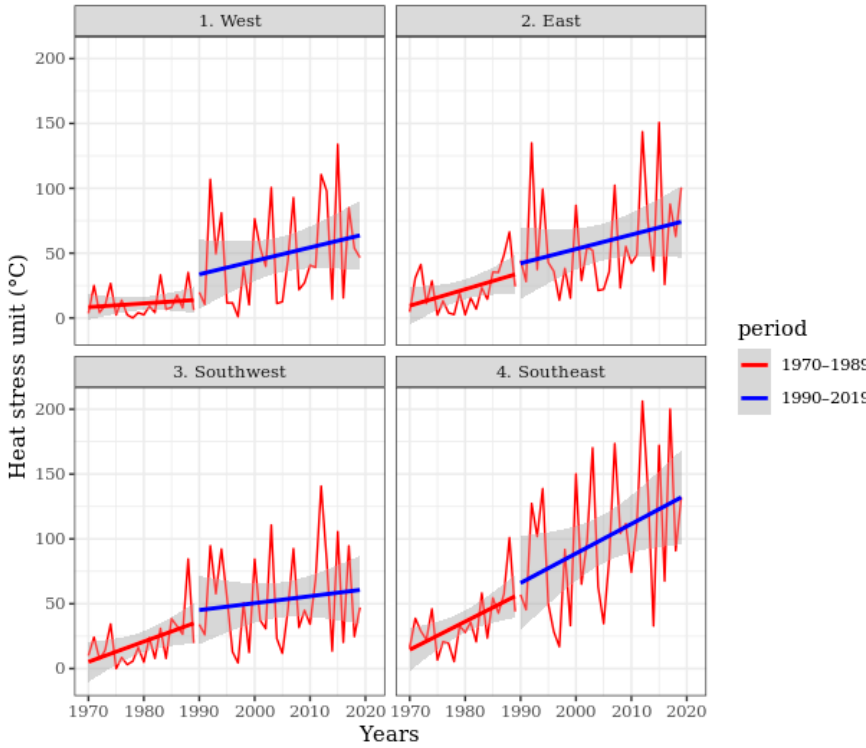
Figure 13. Heat stress units in the four investigated regions divided into two periods (1970–1990 and 1991–2019). Table 5. Effect of technological development and heat stress on the average yield of maize in Hungary